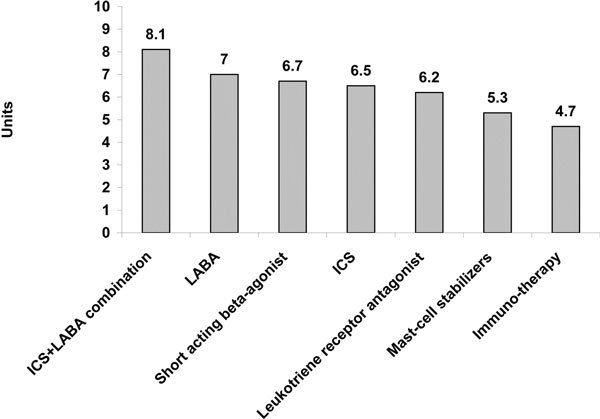
Average physicians satisfaction with currently available asthma treatments. Question: On a scale of 1-10 where "1" means "extremely dissatisfied" and "10" means "extremely satisfied" how satisfied are you with these currently available types of medications for treating asthma overall?